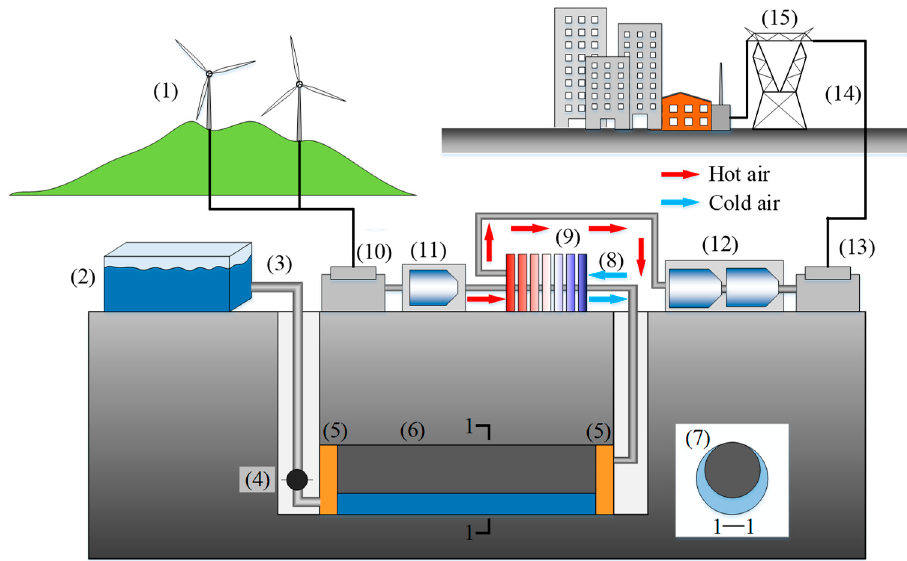
Figure 3. Layout of the new CAES system: (1) renewable energy; (2) reservoir; (3) water pipe; (4) water pump; (5) plugging wall; (6) roadway; (7) flexible bags; (8) compressed air pipe; (9) heat storage unit; (10) electromotor; (11) compressor; (12) turbines; (13) generator; (14) power lines; and (15) power grid.